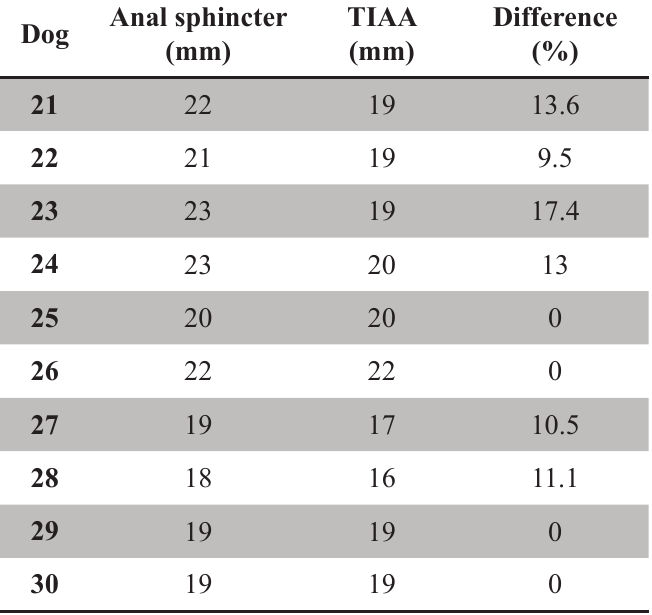
TABLE 3 - Comparison of diameters (only for group III).